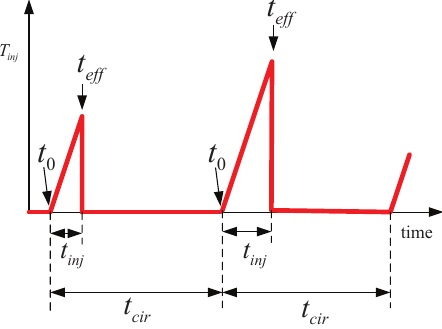
Figure 14. Sawtooth torque injection